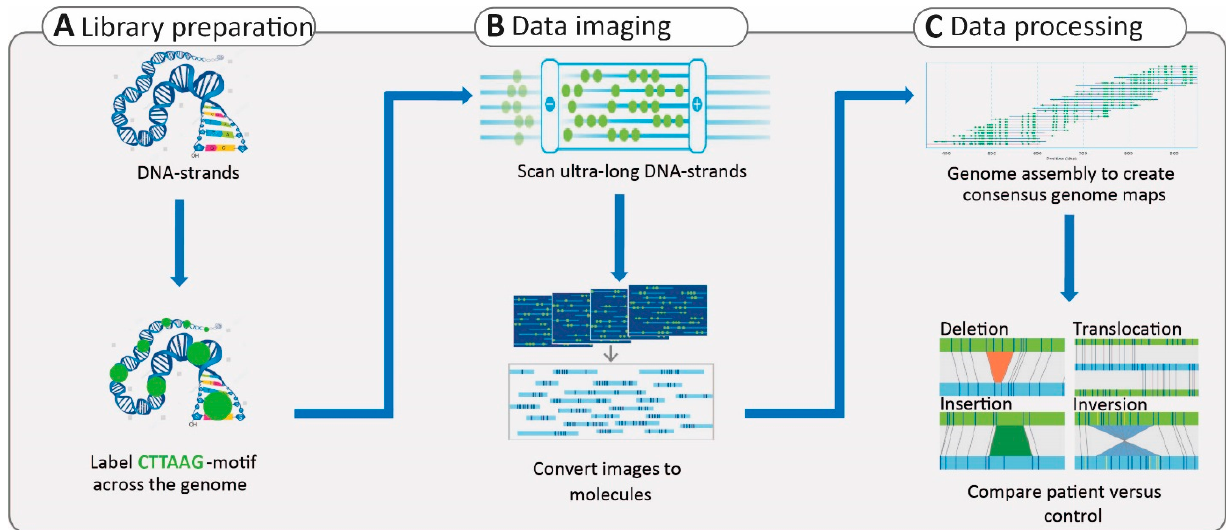
Figure 5. Overview of optical mapping technology. ( A ) High-quality DNA is isolated and later labeled at a 6-mer motif across the genome. ( B ) The labeled DNA is linearized in order to take images of the label patterns in the DNA molecules, and, subsequently, the images are converted to the molecules. ( C ) These molecules are then utilized for genome assembly to generate consensus genome maps. The pattern of labels can be compared between the reference genome and the affected individuals to identify structural variants. The shorter or longer distance between two labels indicates deletion or insertion, respectively. Translocations can be identified by the mapping of a single region in the patient genome to two genomic regions in the reference. The inverted pattern of labels in a patient, compared to that in the reference genome, indicates the presence of an inversion.